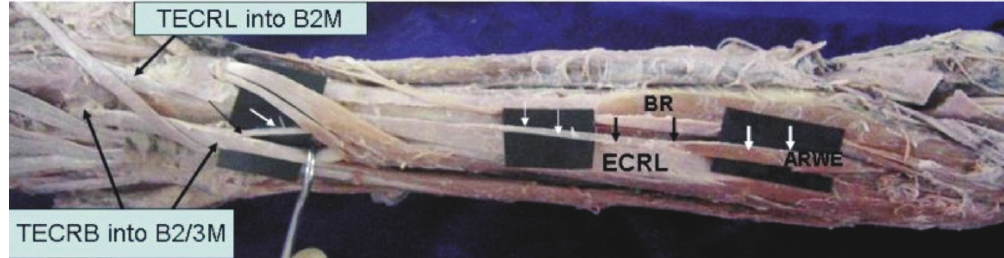
Figure 4 - Extensor compartment of the left forearm and hand region. TECRB into B2/3M, tendon of extensor carpi radialis brevis inserted into the base of the second and third metacarpal bones; TECRL into B2M, tendon of extensor carpi radialis longus inserted into the base of the second metacarpal bone. Note that the downward arrows indicate the course of the additional muscle. The muscle was inserted into the tendon of the ECRB.